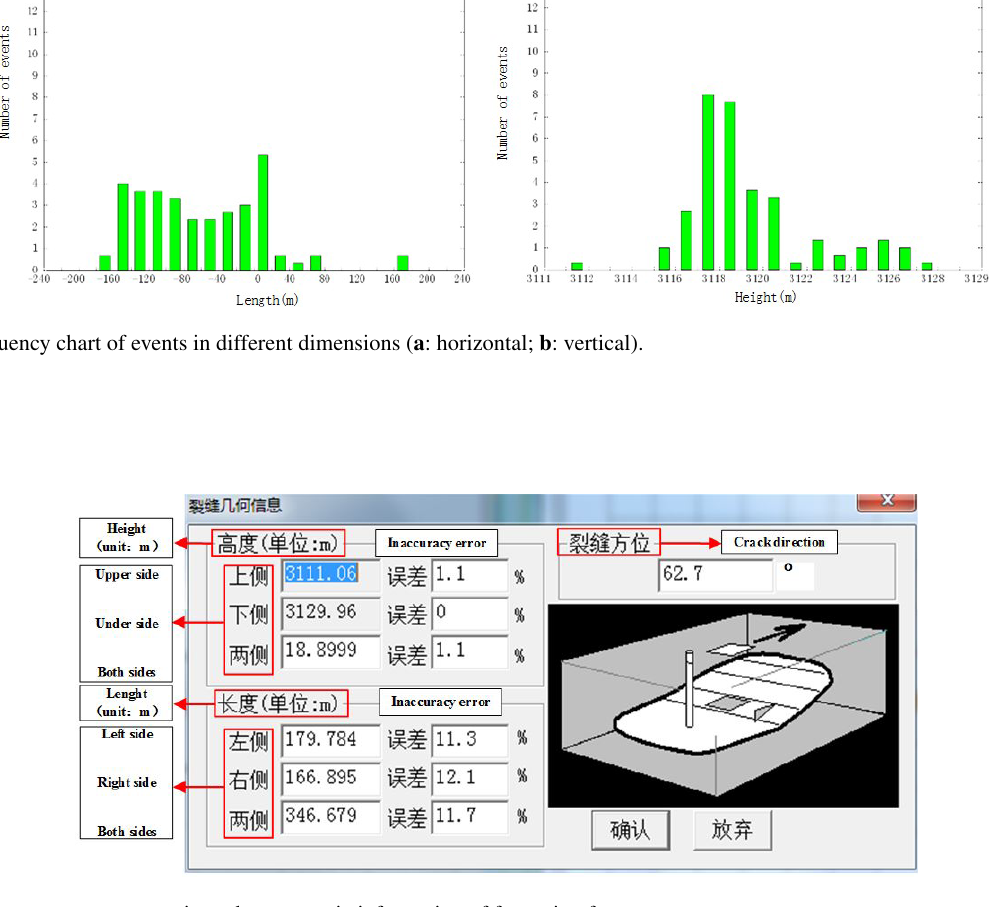
Geosci. Instrum. Method. Data Syst., 10, 91–100, 2021